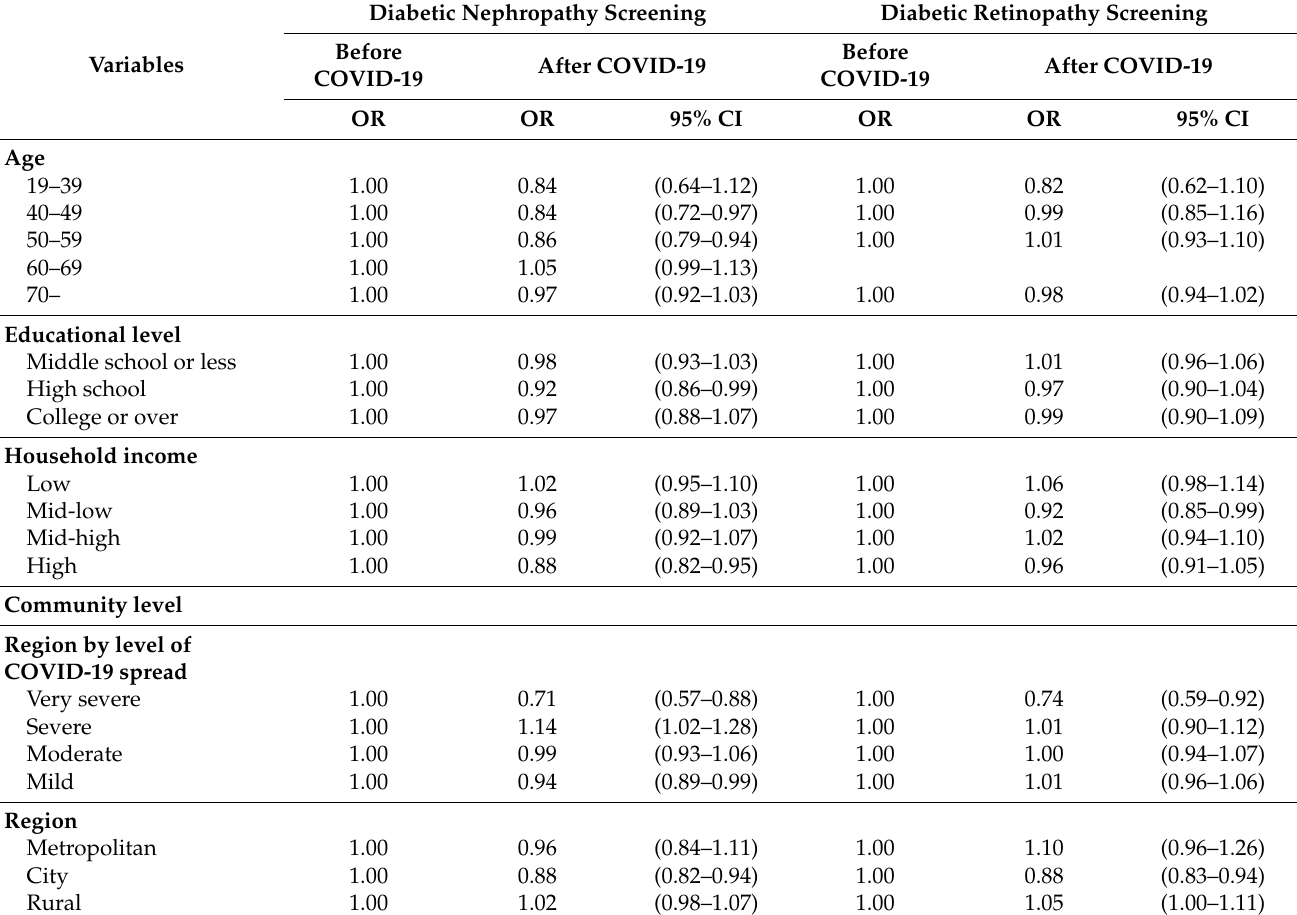
Table 5. The results of subgroup analysis stratified by independent